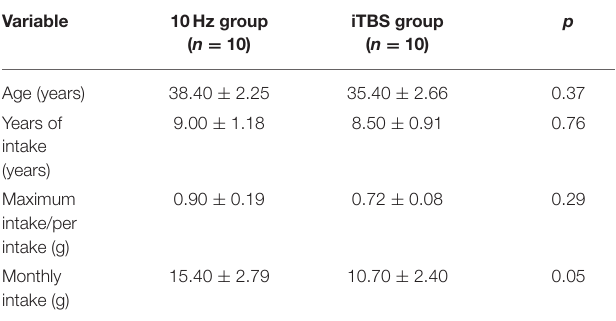
TABLE 1 | Demographic characteristics of patients with MAUD ( M ± SEM